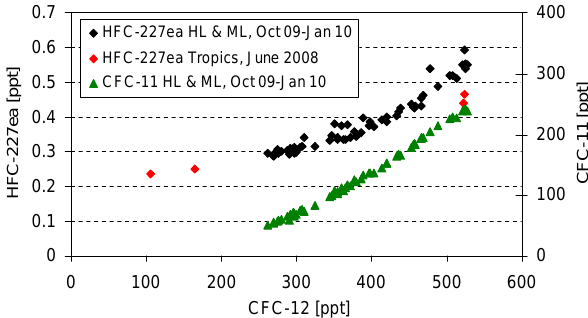
Fig. 4. Stratospheric correlation of HFC-227ea (black) and CFC-11 (green) with CFC-12 as derived from measurements on air samples collected on board the Geophysica high altitude aircraft in high and mid-latitudes (HL and ML). The red points belong to four samples collected with a balloon-borne whole-air sampler in the tropical up- per troposphere and stratosphere (only CFC-12 vs. HFC-227ea dis- played). The 1 σ measurement uncertainties are less than the size of the symbols in all